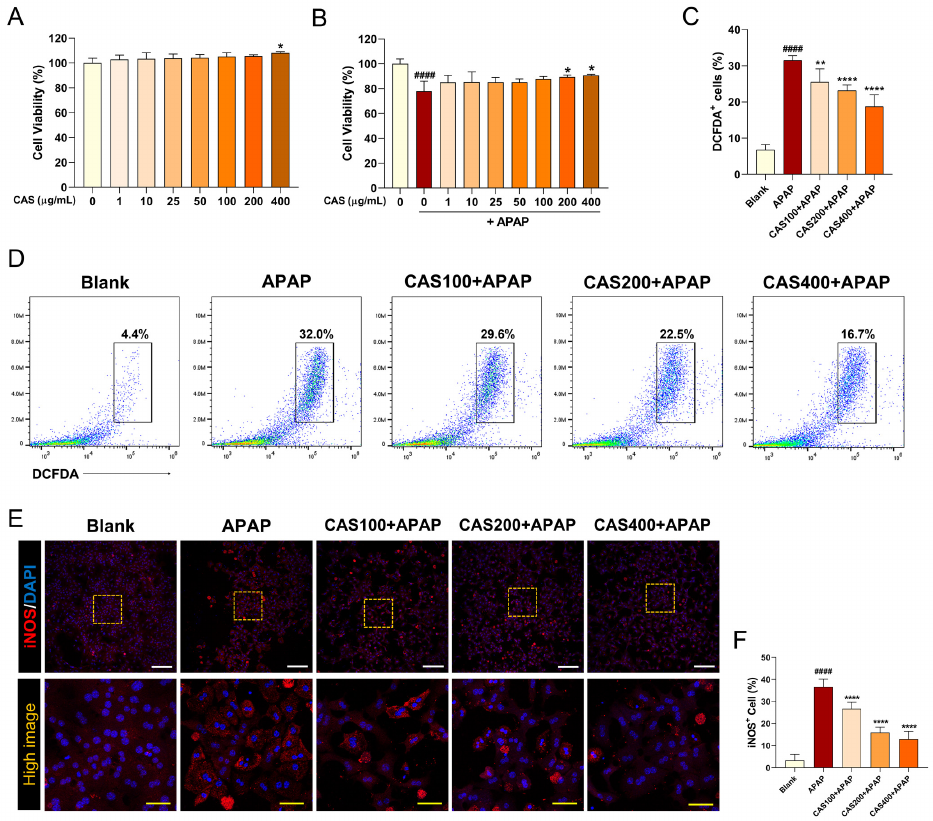
Figure 1. CAS protects primary mouse hepatocytes from APAP-induced hepatotoxicity and oxidative damage by modulating ROS production and iNOS expression. Determination of cell viability in primary hepatocytes pretreated with CAS for 24 h ( A ) without APAP treatment and ( B ) with APAP treatment using a cell counting kit assay ( n = 4). ( C ) Flow cytometric quantification of the percentage of DCFDA + cells upon challenge with APAP ( n = 6). ( D ) Representative flow cytometric dot plot images showing DCFDA-FITC analysis for intracellular ROS levels. ( E ) Representative confocal images of immunocytochemistry for iNOS (red) in the primary hepatocytes of each group. White scale bar = 200 μ m, yellow scale bar = 50 μ m. ( F ) Quantitative analysis of the percentage of iNOS-positivity in DAPI-positive hepatocytes after pretreatment with CAS at 100, 200, and 400 μ g/mL and treatment with 2 μ M APAP ( n = 6). The data are expressed as the mean ± SEM and were analyzed via one-way analysis of variance with Tukey’s post-hoc test. Significant differences are indicated as follows: #### p < 0.0001 vs. blank group; * p < 0.05, ** p < 0.01, and **** p < 0.0001 vs. APAP group. We further evaluated changes in the expression levels of Sirt1 and HO-1, which are involved in hepatoprotection, through an immunochemistry assay. Sirt1 was strongly expressed in untreated hepatocytes, but its expression was significantly suppressed after APAP treatment. In contrast, Sirt1 immunoreactivity significantly increased in a